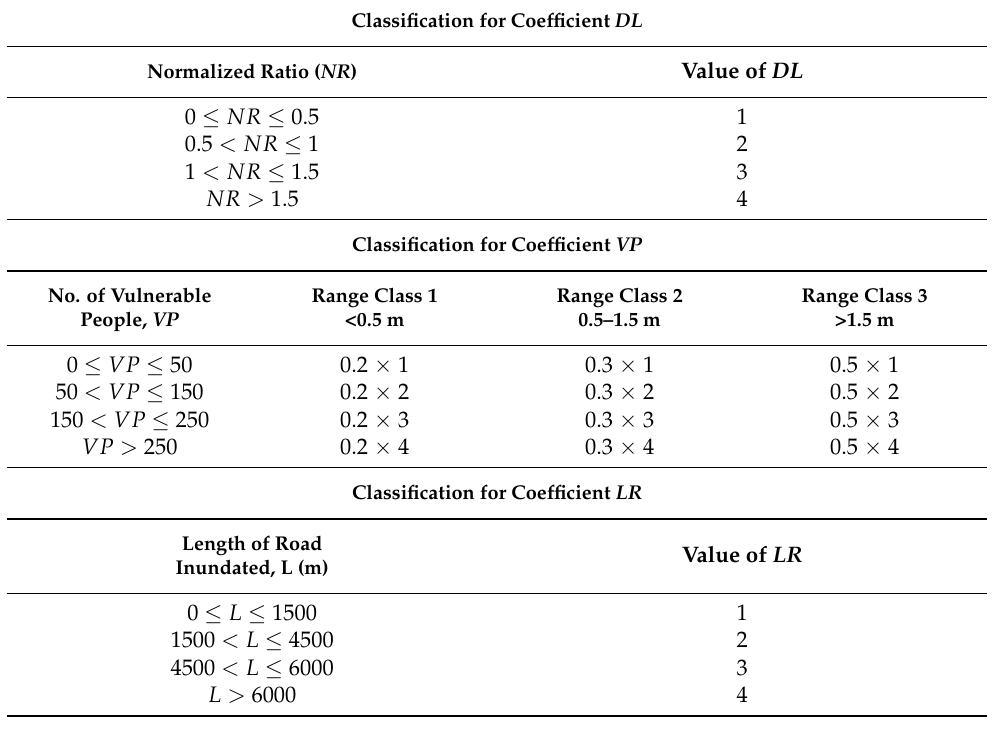
Table 9. Classification for vulnerability index ( VI